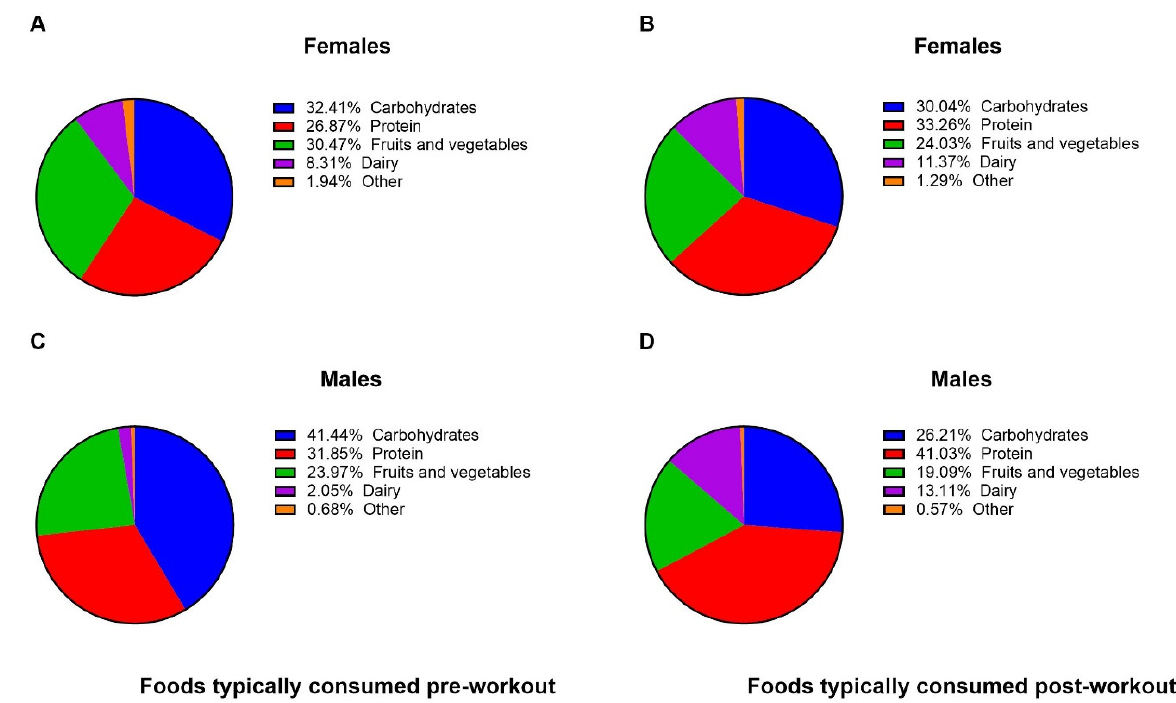
Figure 1. Pre- and post-workout food choices of athletes. Athletes were asked to select all foods they typically consume before and following workouts/practices. Data are presented as percentage of all responses cast among all options (listed in the figure). ( A ): n = 361 total responses; ( B ): n = 466 total responses; ( C ): n = 292 total responses; ( D ): n = 351 total responses.